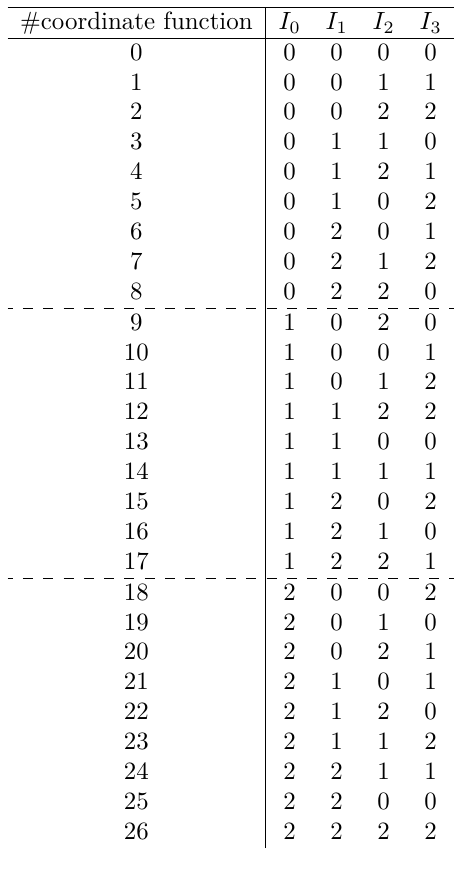
Table 1: Index configuration of our